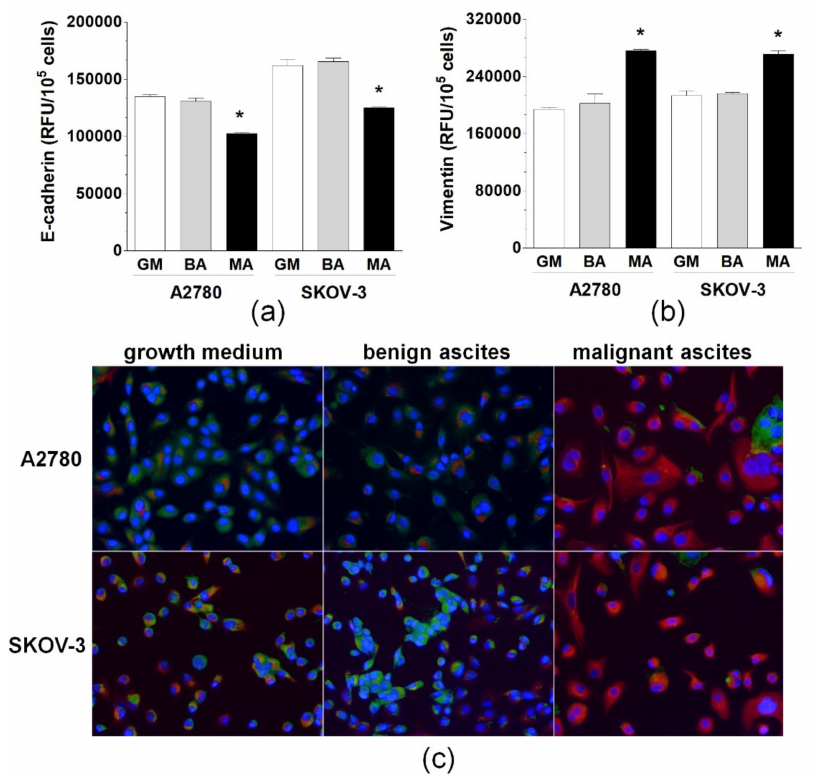
Figure 1. Expression of E-cadherin ( a ) and vimentin ( b ) in A2780 and SKOV-3 cells exposed to growth medium (GM), benign ascites (BA), and malignant ascites (MA). Panel ( c ) shows representative results of the dual immunostaining of E-cadherin (green) and vimentin (red) in the cancer cells. DAPI staining (blue) indicates the nuclei (magnification × 100). Asterisks (*) indicate significant differences ( p < 0.05) compared with ovarian cancer cells exposed to benign ascites. Experiments were performed with the cancer cells used in hexaplicates. The benign and the malignant ascites were obtained from eight different patients per group. RFU—relative fluorescence